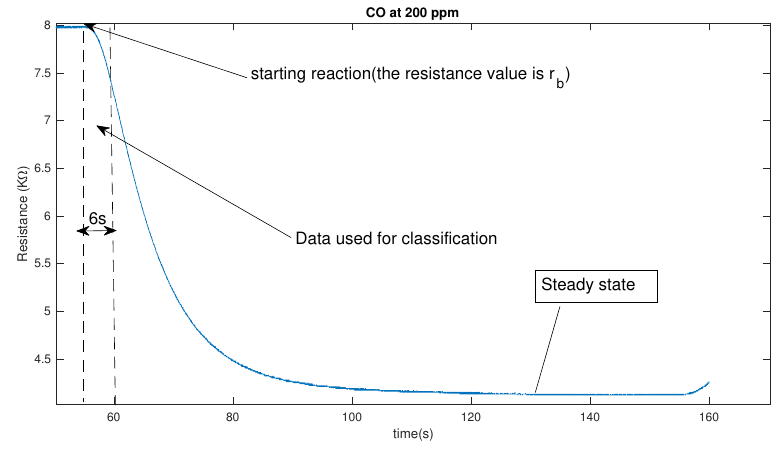
Figure 3. The response of a metal-oxide based chemical sensor to 200 ppm of